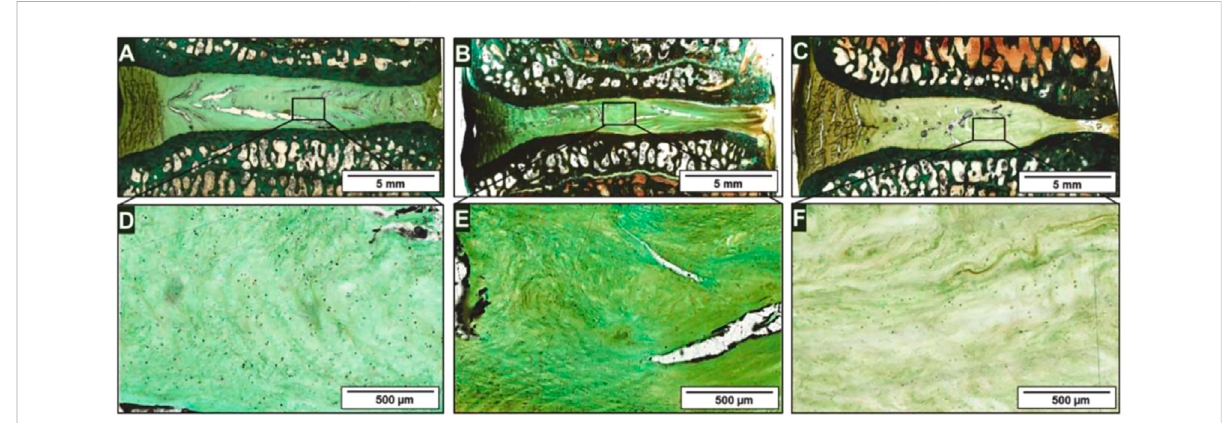
FIGURE 2 After12 months ofexperiment,Masson-GoldnerhistologicallightmicroscopywasusedtoobservetherepresentativeIVDsegmentsinasheep model. The healthy segment view (A) and enlarged view of the NP region (D) ; The IDD segment (B) and enlarged view of the NP region (E) ; The IDD segment receiving scaffolds injection (C) and enlarged view of the NP region (F) . Reproduced with permission from (Friedmann et al., 2021).